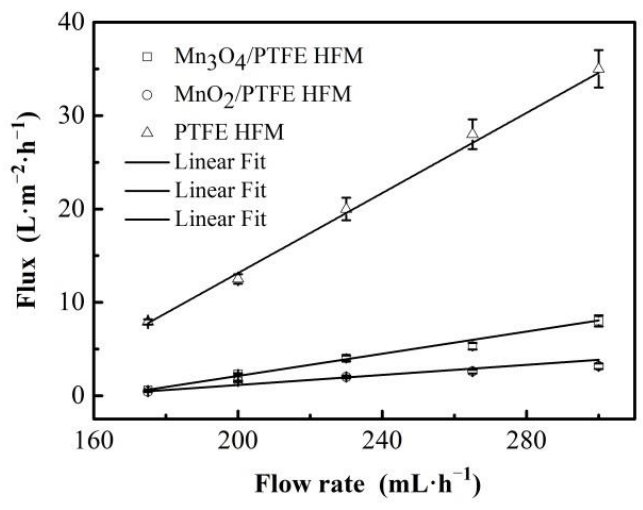
Figure 8. The flux of hollow fiber membranes.